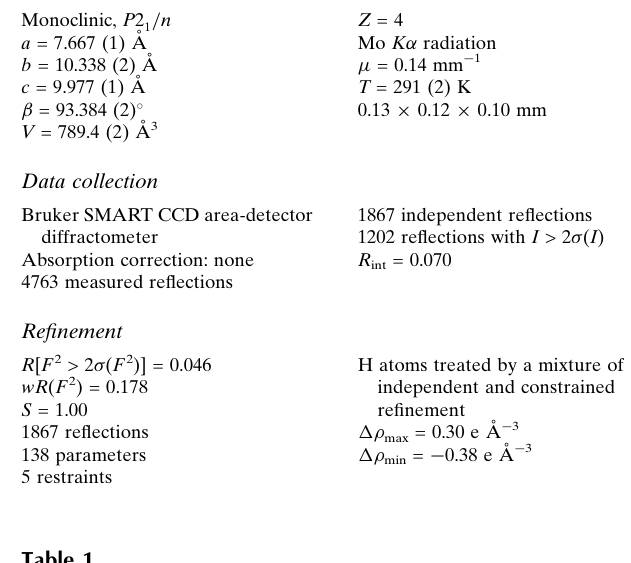
Hydrogen-bond geometry (A˚ , (cid:3)